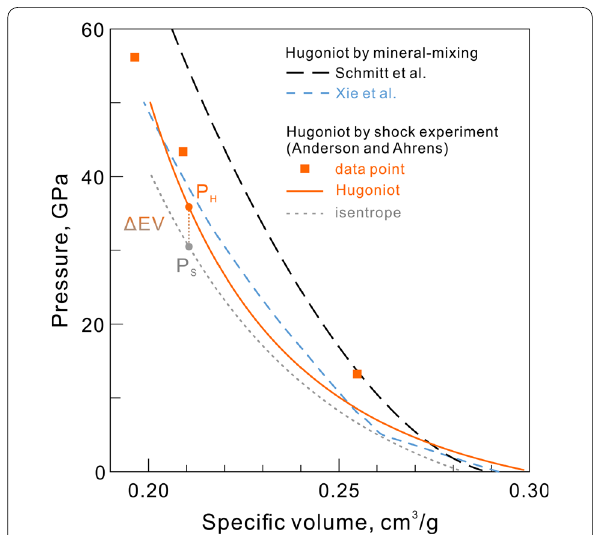
Fig. 1 Pressure–volume Hugoniots of L chondrite from mineral mixing models (Schmitt et al. 1994; Xie et al. 2006b) and shock experiment (Anderson and Ahrens 1998) along with a calculated dense isentrope. Δ E V is the internal energy difference between the isentropic and Hugoniot state of the same specific